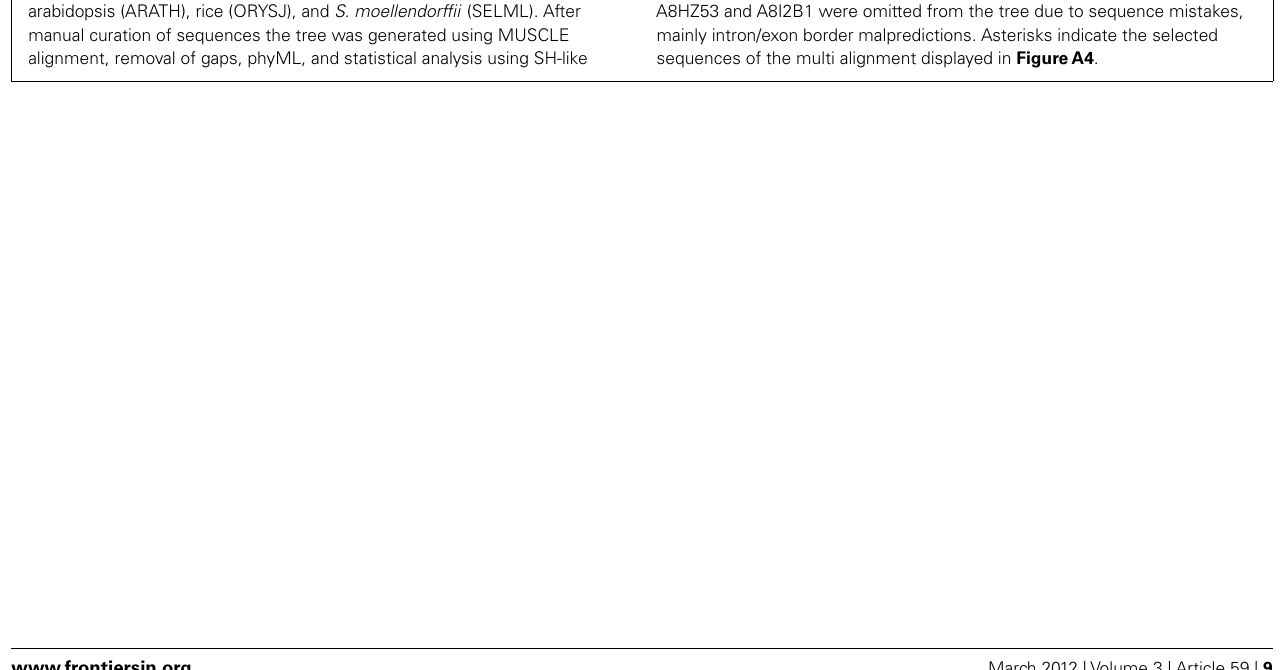
FIGUREA3 | Phylogenetic trees of DUF23 including GT92, containing proteins from selected plants. The tree includes sequences from arabidopsis (ARATH), rice (ORYSJ), and S. moellendorffii (SELML). After manual curation of sequences the tree was generated using MUSCLE alignment, removal of gaps, phyML, and statistical analysis using SH-like